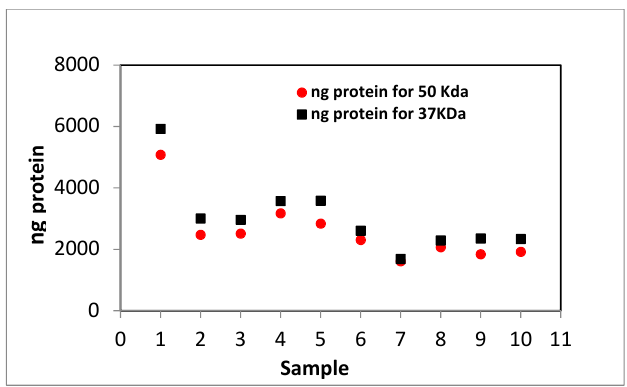
Figure 2. Densitometry results for the amount of protein obtained for 50 kDa band and the 37 kDa in different samples from SDS ‐ PAGE. Samples 1 ‐ 4: D0–D3 (D = dialyzed and the number corresponds to days); samples 5–10: DF1, DF3, DF5, DF8, DF10, DF14 (DF = dialyzed and diafiltered and the number corresponds to cycles).